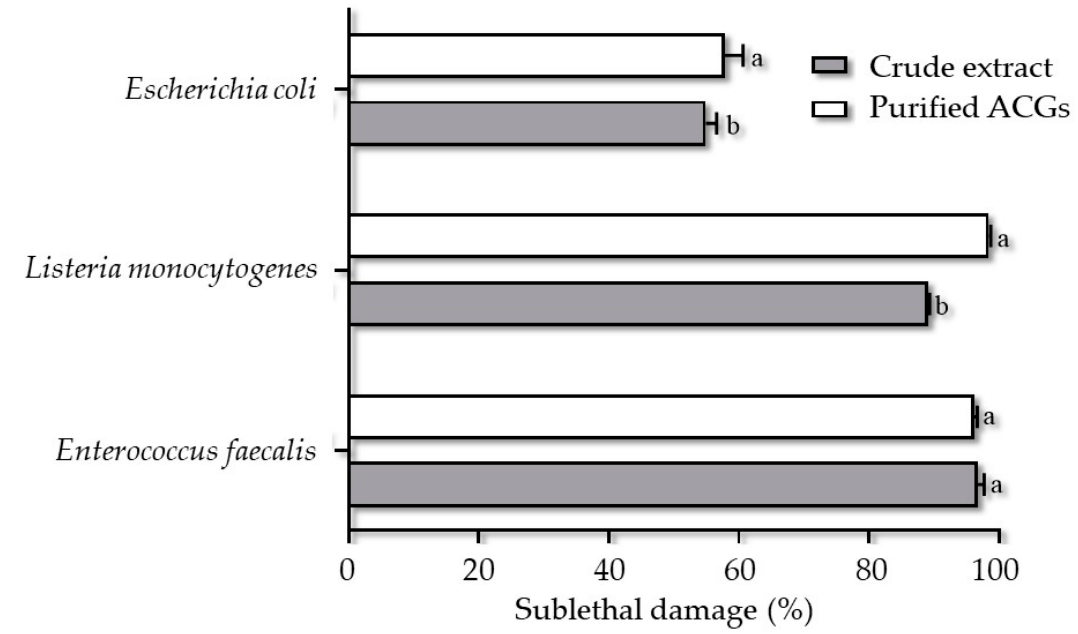
Figure 4. Sublethal injury of crude extract acetogenins and purified acetogenins on Enterococcus faecalis , Listeria monocytogenes , and Escherichia coli. Different letters (a, b) indicate significant statistical differences between treatments ( α = 0.05) by each concentration.